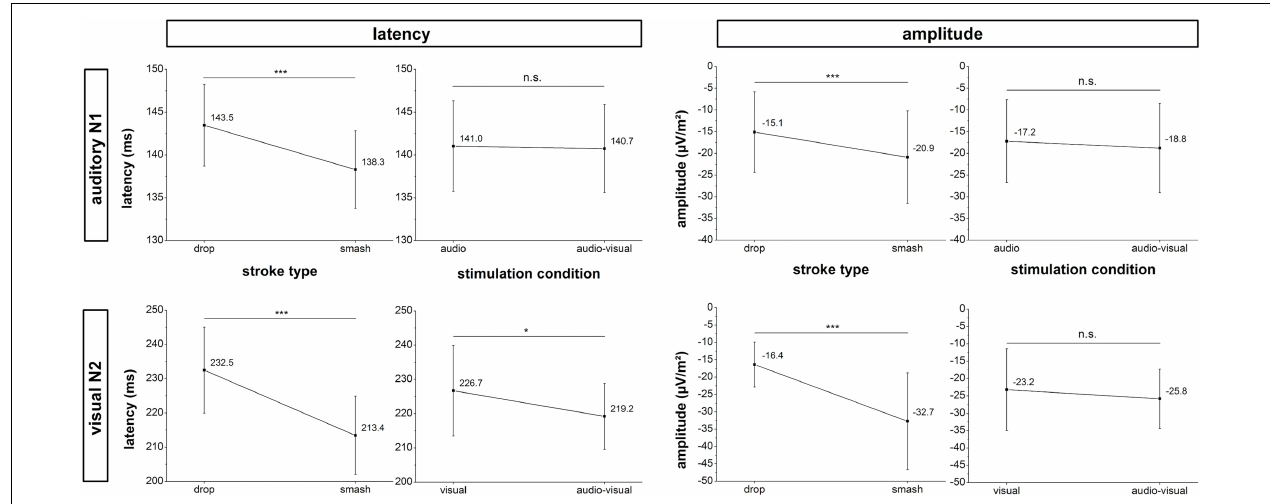
FIGURE 4 | Amplitude and latency analyses for the auditory N1 (top row) and visual N2 (bottom row) potential. Error bars reflect 95% confidence intervals. *: p < 0.05, ***: p < 0.001, n.s.: not significant.